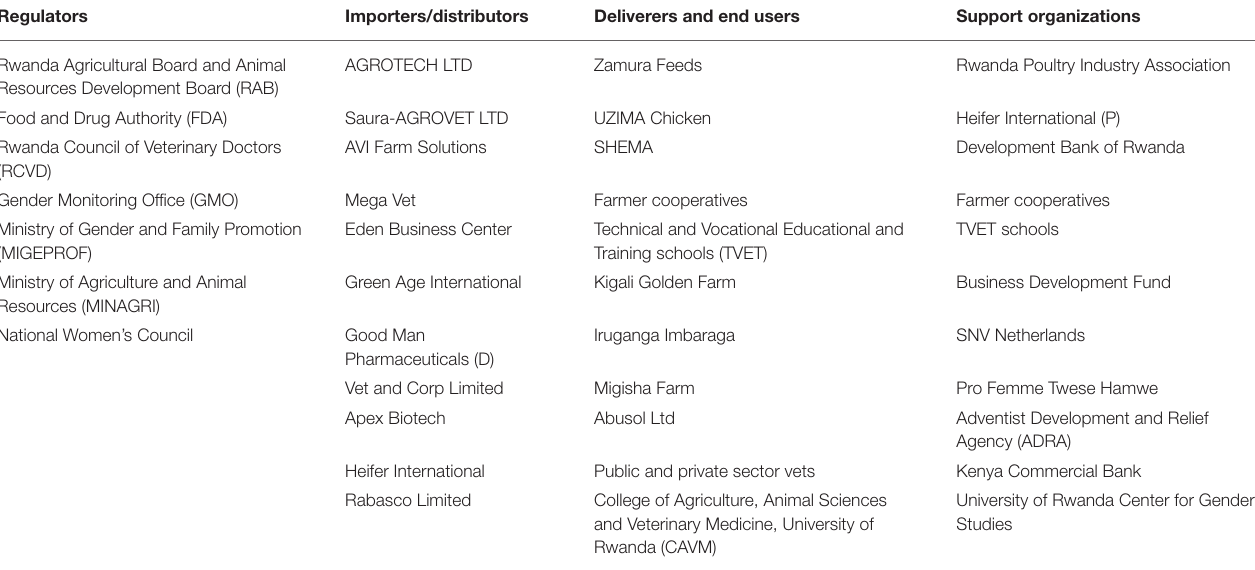
TABLE 1 | Organizations engaged in the Rwanda LVVC stakeholder mapping exercise in November 2019.